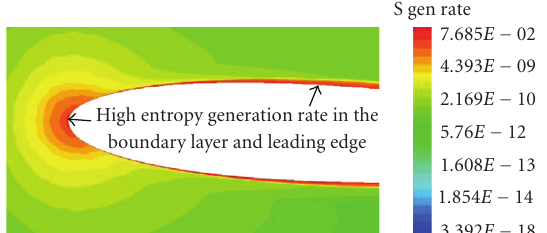
Figure 4: Entropy production rates computed with high-fidelity CFD code can be usefully identify regions of numerical error and where the second-law is violated. For system design, the computation would be a useful way of identifying regions of irreversible